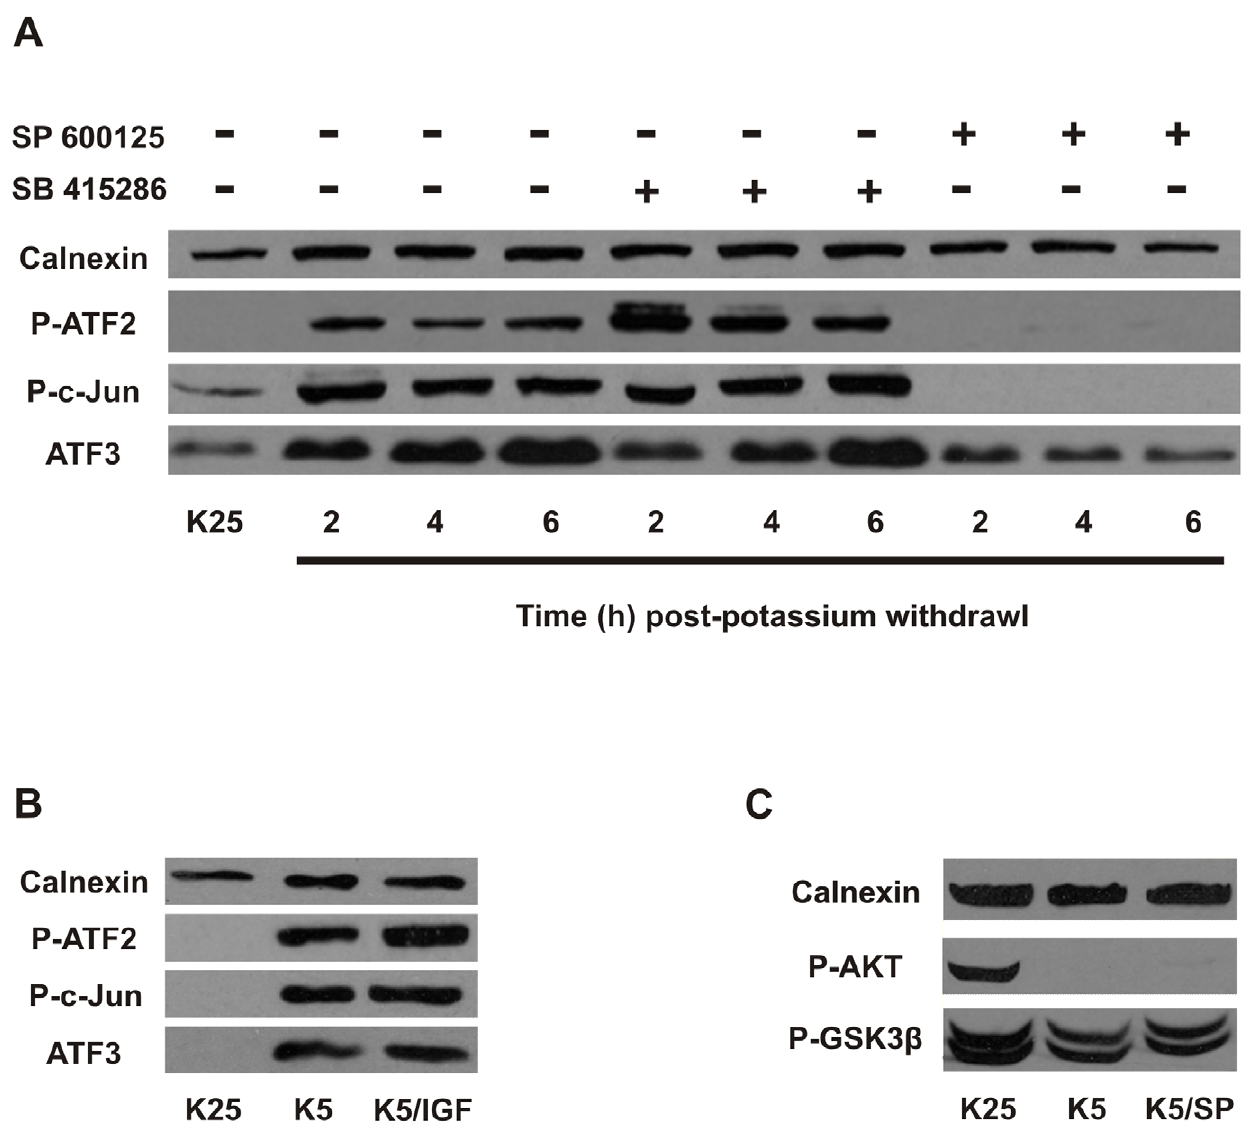
Figure 9. The JNK and AKT/GSK3 b pathways signal independently during potassium withdrawal in CGNs. A, CGNs were maintained in high potassium medium (K25) or subjected to potassium withdrawal (K5) in the presence or absence of the JNK inhibitor SP600125 (10 m M) or the GSK3 b inhibitor SB415286 (30 m M). Protein extracts were collected at 2, 4 and 6 hours and Phospho-ATF2, Phospho-c-Jun and ATF3 levels were analyzed by western blot. B, CGNs were subjected to potassium withdrawal in the presence or absence of 200 nM IGF-1. Protein extracts were collected after 6 hours and were analyzed for Phospho-ATF2, Phospho-c-Jun and ATF3 protein levels by western blot. C, CGNs were subjected to potassium withdrawal in the presence or absence of 10 m M SP600125 (SP) and protein extracts were collected after 6 hours and analyzed by western blot for Phospho-AKT and Phospho-GSK3 b levels.